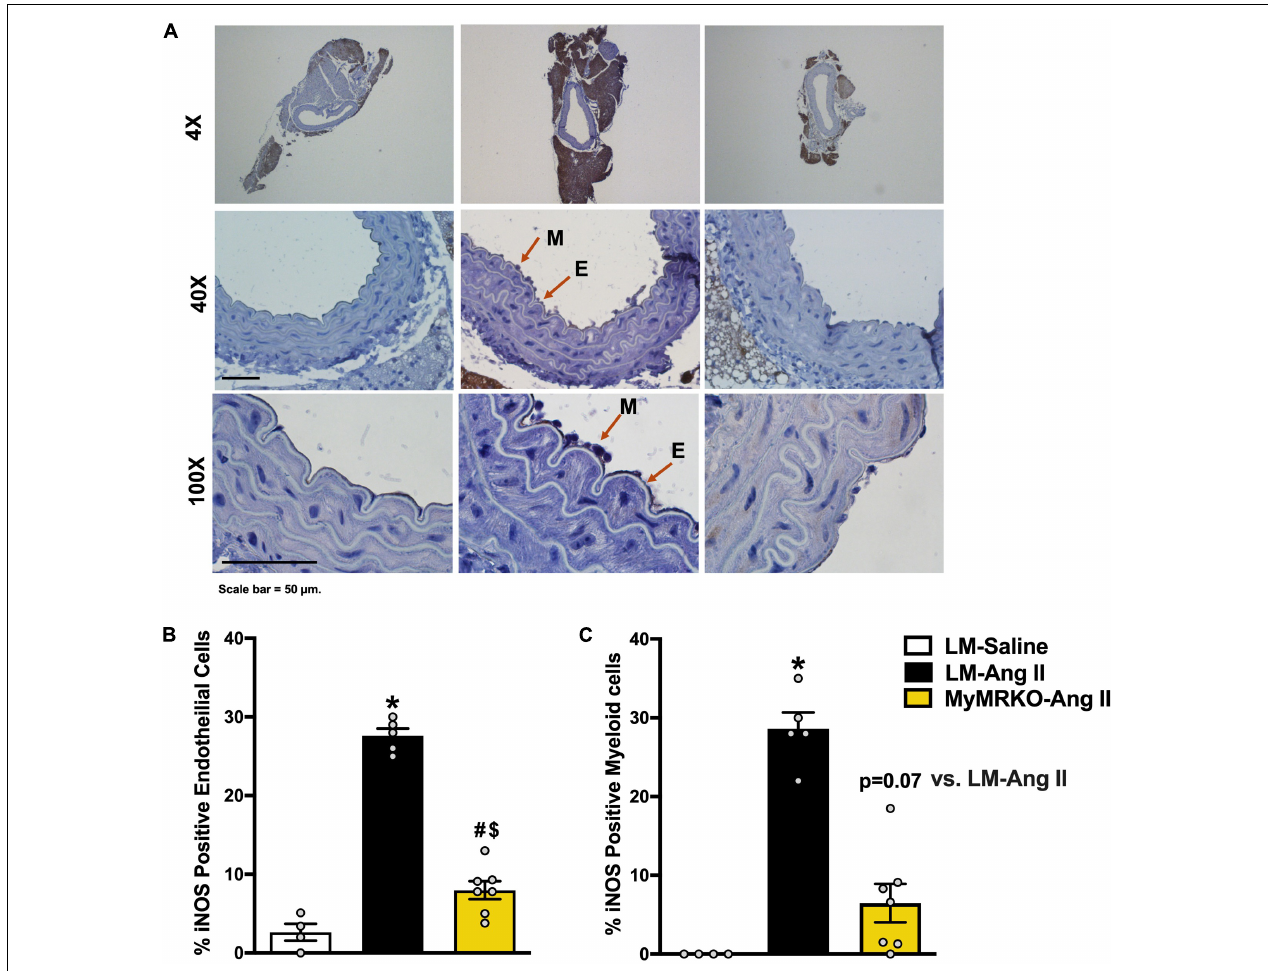
FIGURE 3 | Deletion of myeloid cell MR decreases Ang II-induced iNOS expression in myeloid and endothelial cells. (A) Representative images of iNOS staining in myeloid and endothelial cells at 4 × , 40 × , and 100 × of the different cohorts. (B) iNOS-positive endothelial cells and (C) iNOS-positive myeloid cells. Results are expressed as percent positive cells. * p ≤ 0.05 LM-Ang II vs. LM-Saline; $ p ≤ 0.05 MyMRKO-Ang II vs. LM-Saline; # p ≤ 0.05 LM-Ang II vs. MyMRKO-Ang II. n = 4–7 for all groups. iNOS, inducible nitric oxide synthase; LM, littermate; Ang II, angiotensin II; MyMRKO, myeloid mineralocorticoid receptor